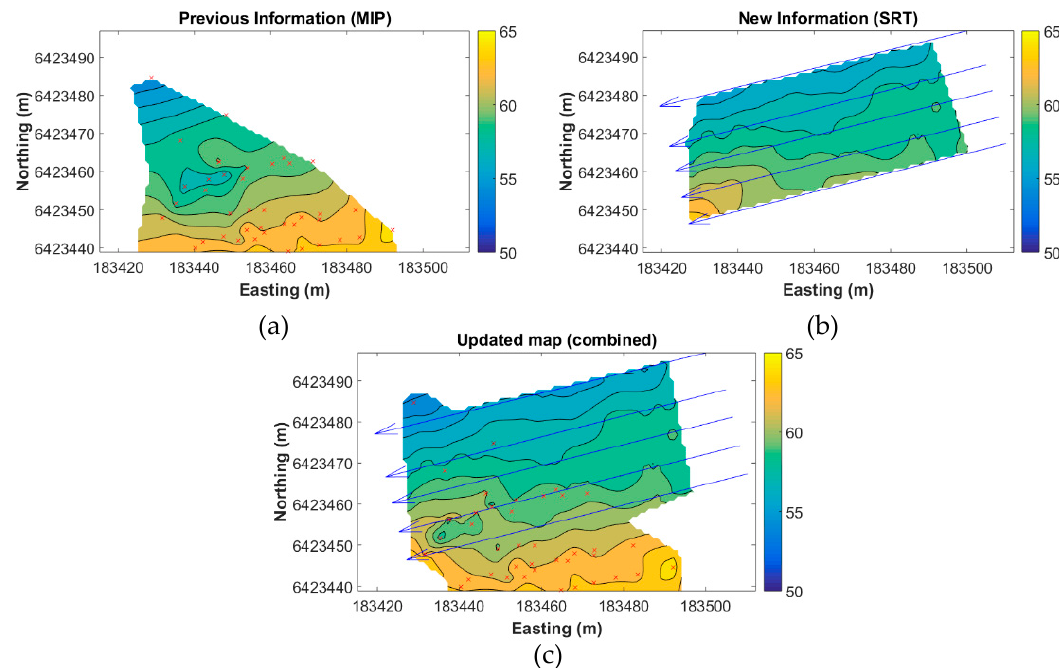
Figure 6. Interpolated surface map of depth to bedrock from the ( a ) MIP soundings [27,28] ( b ) Seismic Refraction tomography (SRT) ( c ) combined. The bedrock surface is plotted with absolute elevation (meters above sea level). Coordinates are in SWEREF99 TM12.